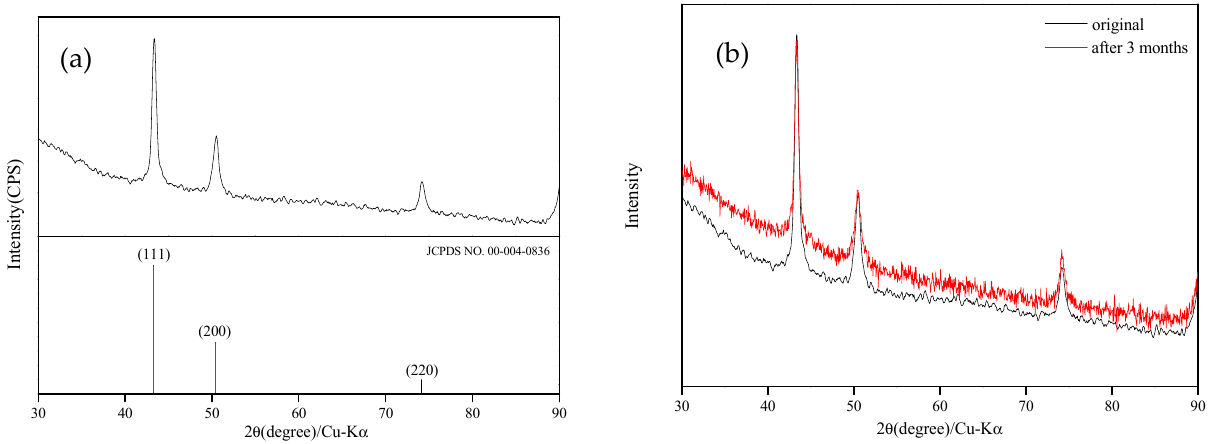
Figure 11. XRD spectrograms of ( a ) CuNPs and ( b ) CuNP solution after 3 months.